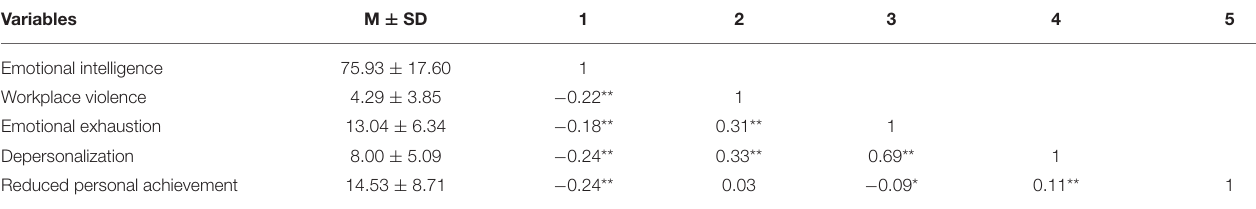
TABLE 3 | The Pearson correlation analysis among research variables.